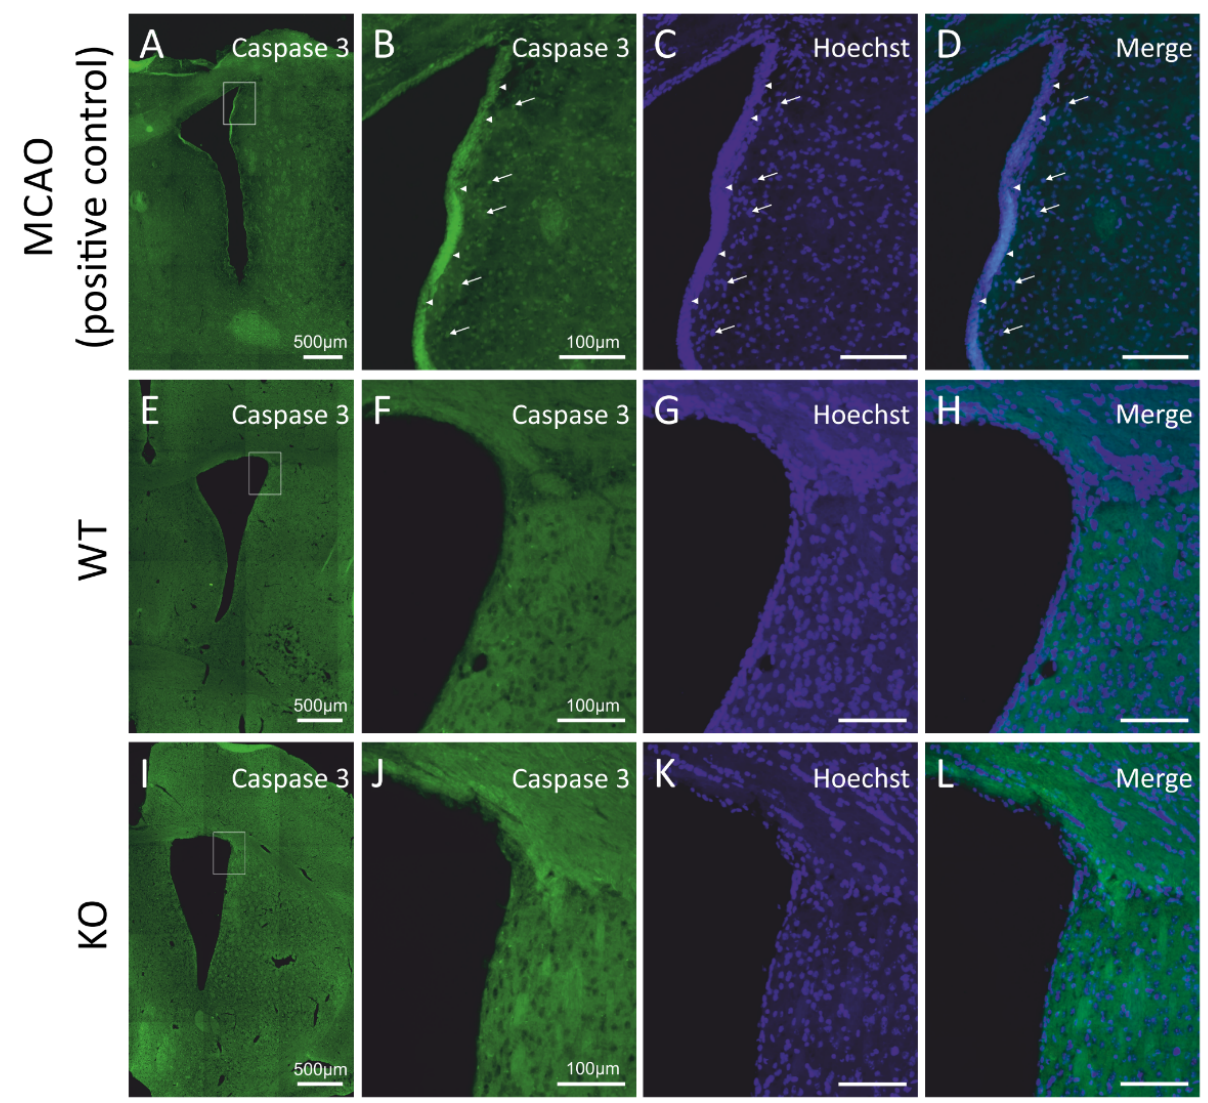
Figure 2. Cyclin D2 deficiency does not induce apoptosis in the subventricular zone under physiolog- ical conditions. ( A – L ) Immunoreactivity of cleaved caspase-3, a hallmark of apoptosis. No positive signal of active caspase-3 in the SVZ of ( E – H ) WT and ( I – L ) cD2-KO mice was observed compared to the positive control tissue (rats exposed to MCAO (middle cerebral artery occlusion); a model of stroke-induced apoptosis, A – D ). Arrowheads indicate active caspase-3 signals from cumulated cells at the edge of the SVZ and the lateral ventricle (LV), while arrows point to more distally localized single caspase-3(+) profiles within 50 µ m from the LV.